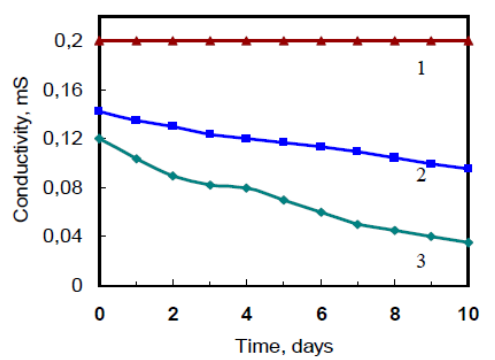
Figure 2. The stability of PANI—H 6 P 2 W 18 O 62 films deposited from solutions with different concentration of hydrochloric acid: 1–1.0 M; 2–0.5 M; 3–0.1 M.